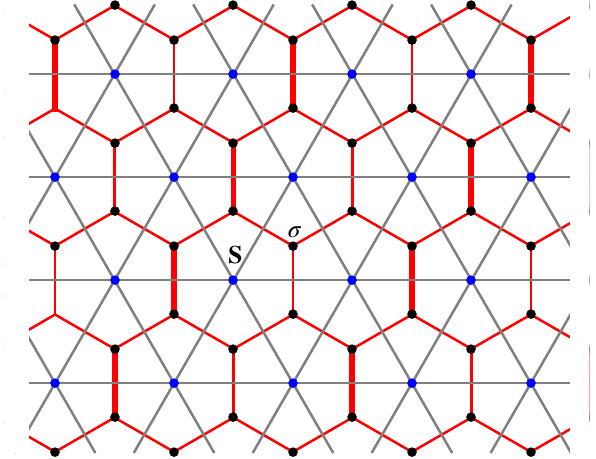
Figure 5: Illustration of the 2D Hamiltonian, where spin-1 / 2’s form a triangular lat- tice, and Ising spins reside on the dual honeycomb lattice. Thicken bonds denote frustrated Ising